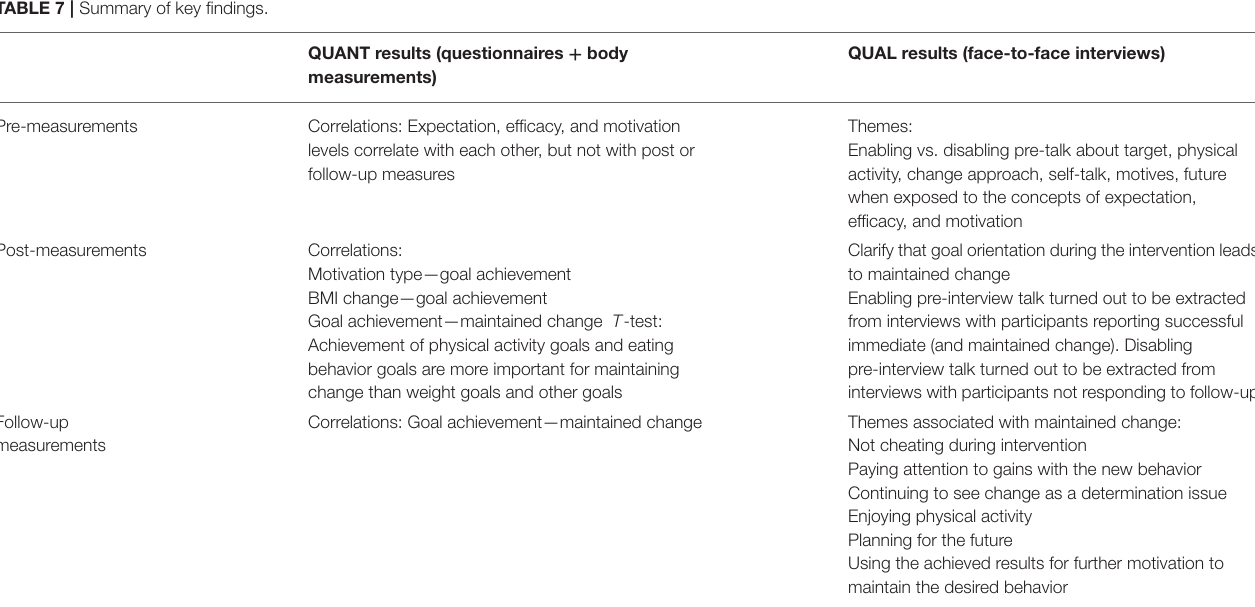
TABLE 7 | Summary of key